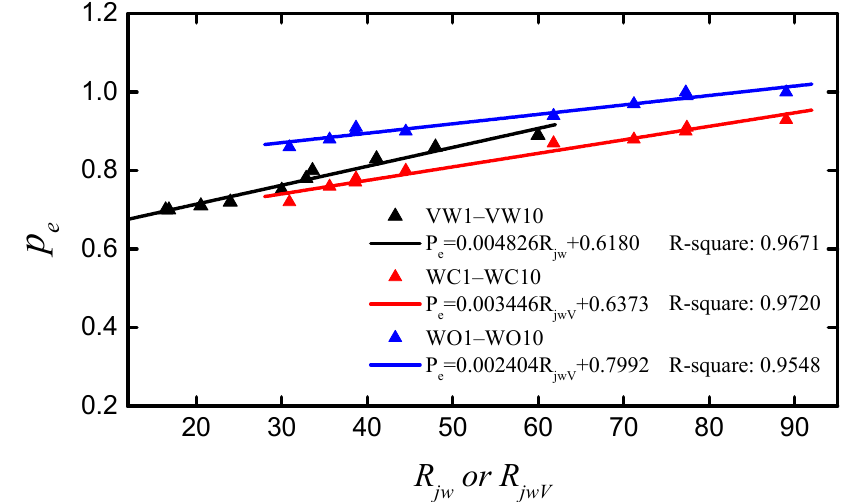
Figure 9. The regression equations of p e versus R jw or R jwV for the vertical jet (shown in black line), the horizontal jet along the wave direction (shown in red line) and the horizontal jet opposing the wave direction (shown in blue line).